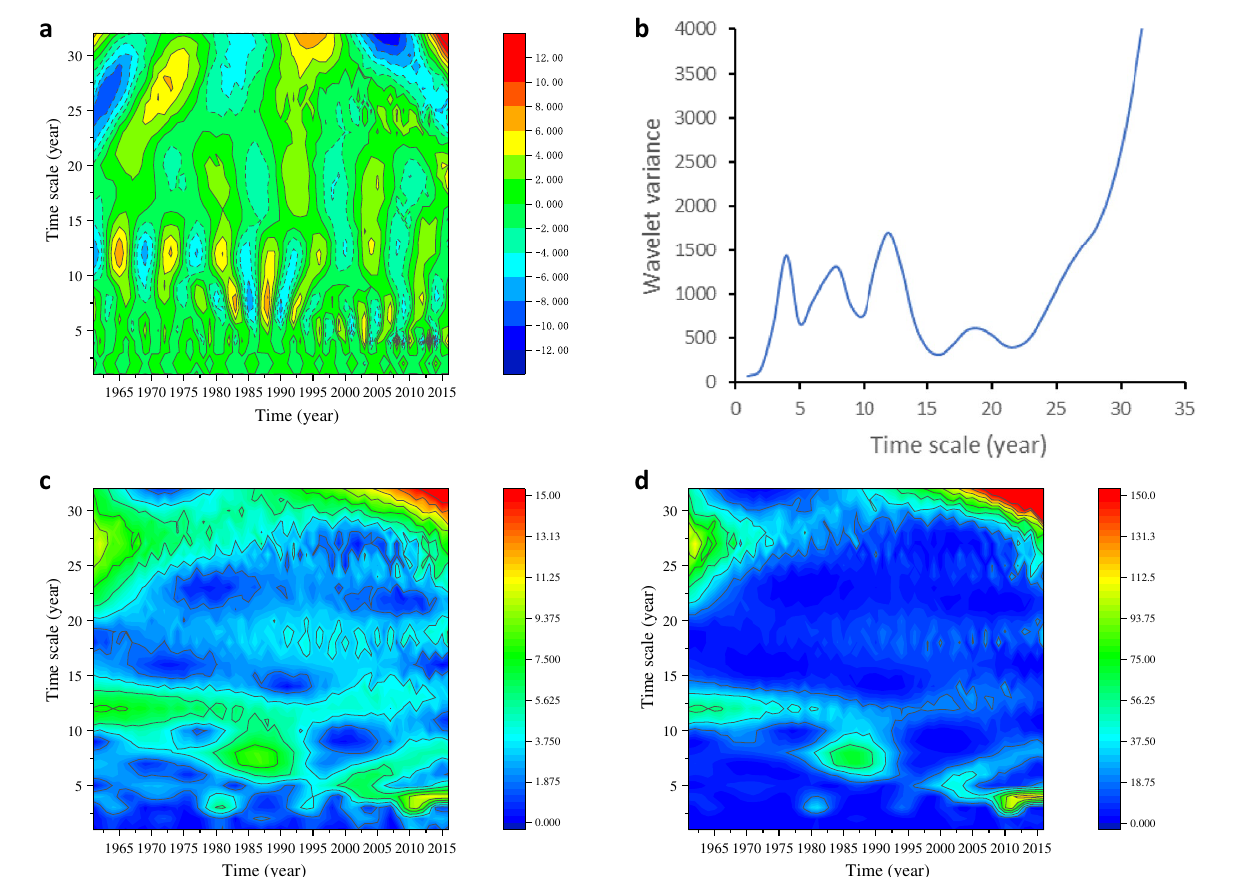
Figure 3. ( a ) Real contour map of the annual precipitation wavelet coefficients ( b ) Wavelet variance of the annual precipitation ( c ) Wavelet coefficient module contour map of the annual precipitation ( d ) Wavelet coefficient module square contour map of the annual From the Figure. 4k, there are three main timescale structures in the area series from 1961 to 2016, which are roughly of 3 to 7 years, 11 to 17 years, and 21 to 26 years. The corresponding wavelet coefficients of 11–17a are large, and the period is obvious. As can be seen from the wavelet variance of the area Figure. 4l, the three main cycles are 24a, 13a and 5a, of which the 24a period persisted from 1961 to 2016, and the 13a period only existed from 1961 to 1985.